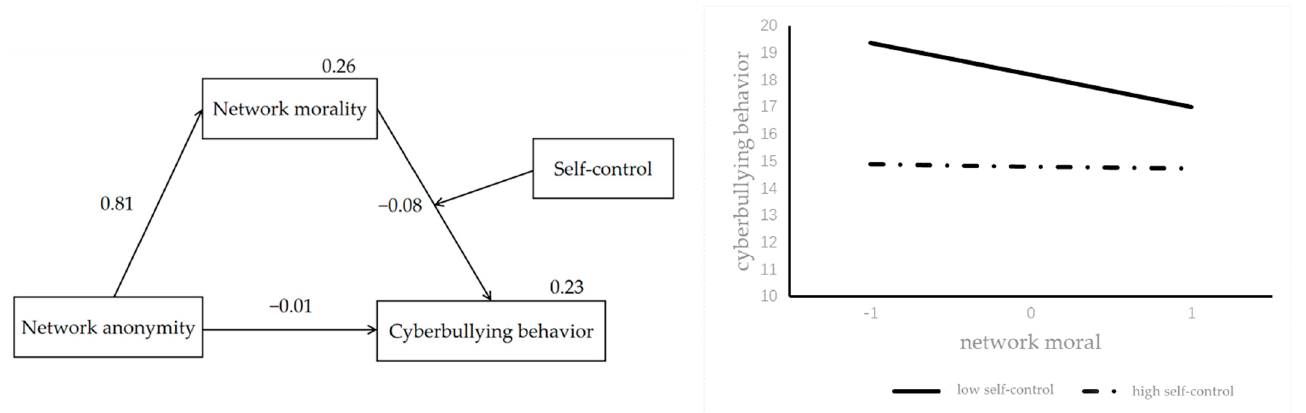
Figure 2. The model with indices ( left ) and the moderating role of self-control in the linkage of network morality and cyberbullying behavior ( right ).